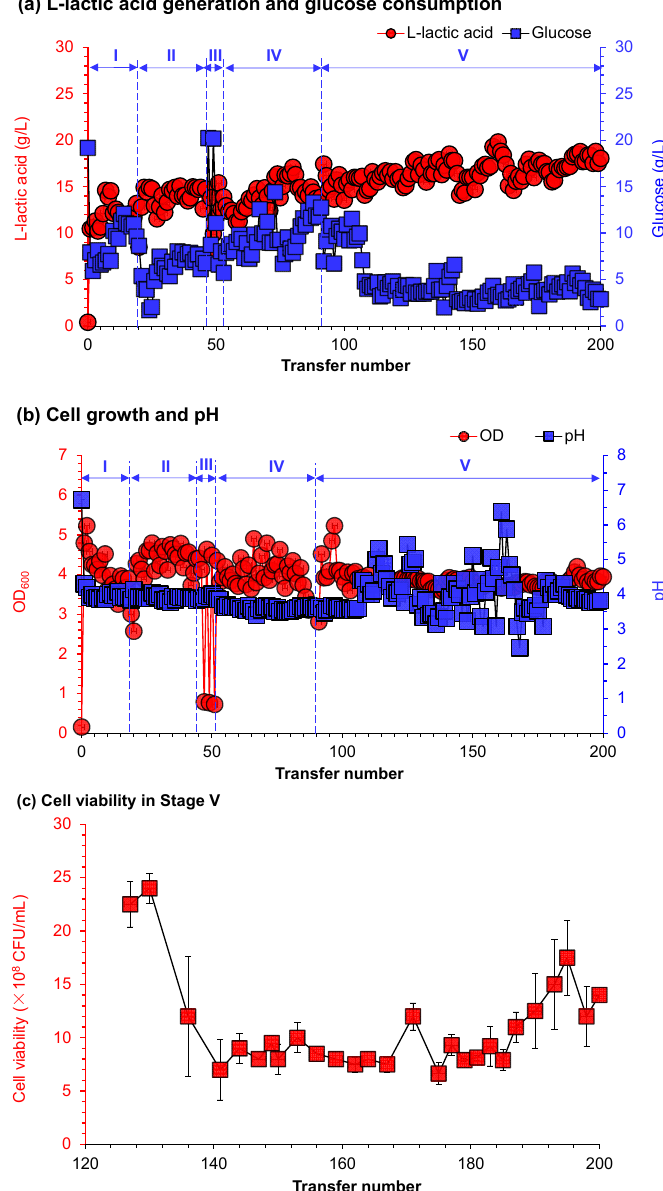
Figure 2. Low pH adaptive evolution of the parental strain P. acidilactici ZY271. ( a ) L-lactic acid generation and glucose consumption; ( b ) Cell growth and pH; ( c ) Cell viability. Five stages were switched during long-term adaptive evolution. The successive transfers were conducted at 42 °C and 150 rpm, and the inoculum ratio was 10% ( v / v ). OD 600 , pH, L-lactic acid, glucose, and cell viability were measured at the end of each transfer. The details of each stage were in Materials and Methods, Section 2.5.